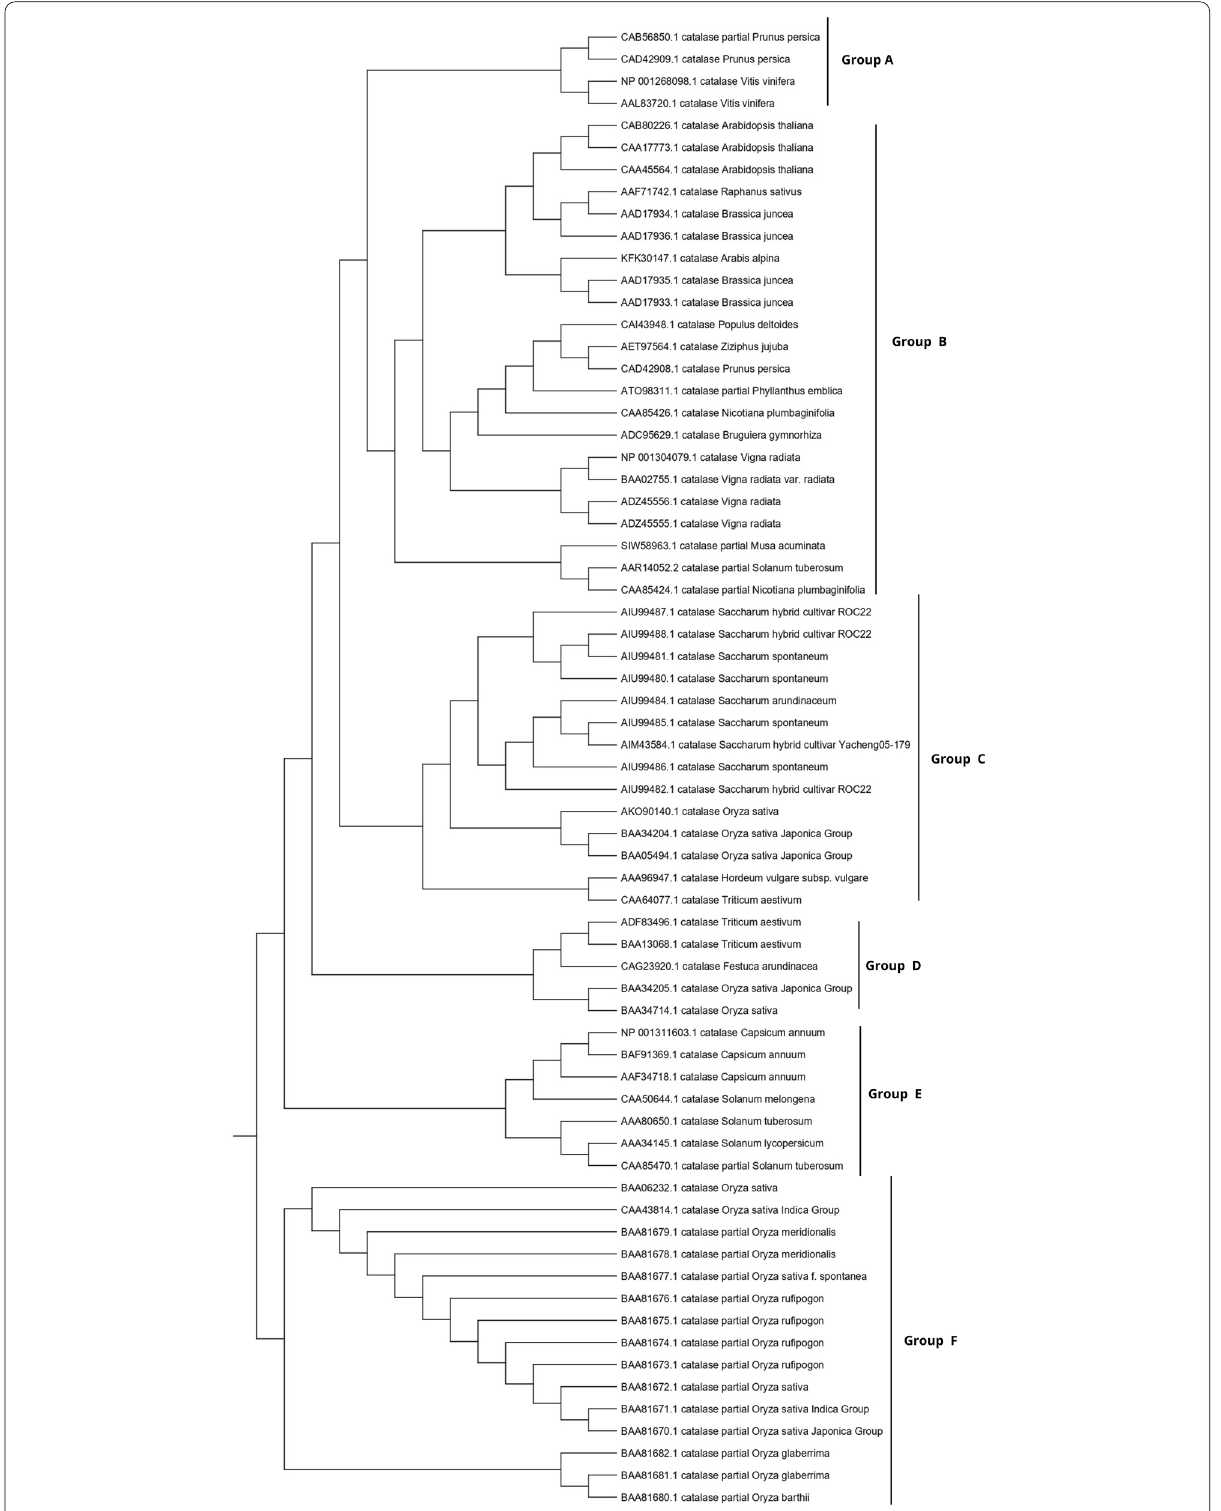
Fig. 1 Construction of phylogenetic tree of protein sequences of plant catalases using NJ method. The unique clusters A, B, C, D, E , and F are highlighted, consisting of 4, 22, 12, 5, 7, and 15 members,